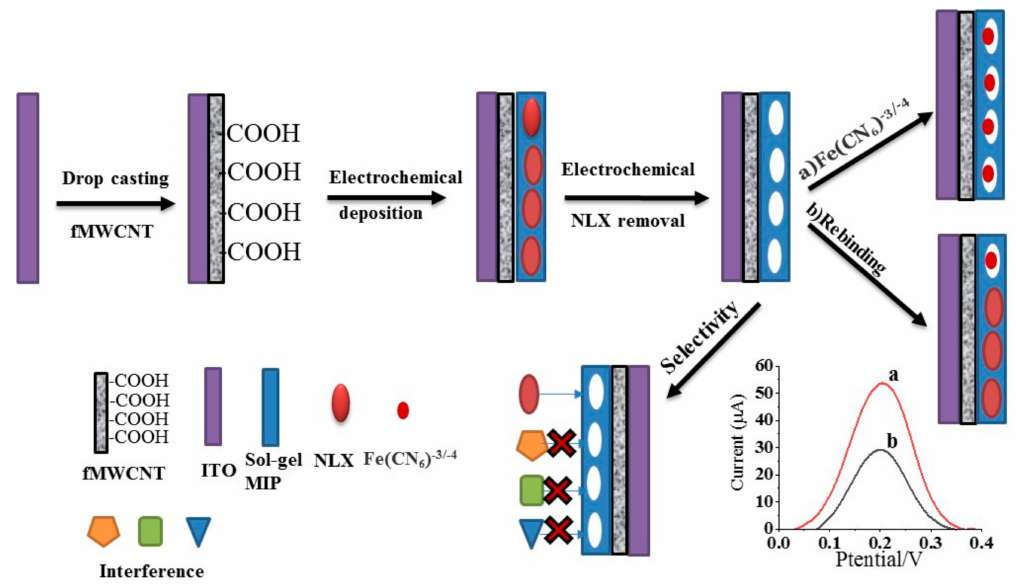
Scheme 1. Illustration of stepwise fabrication of pyrrole@sol-gel MIP sensor and the NLX detection